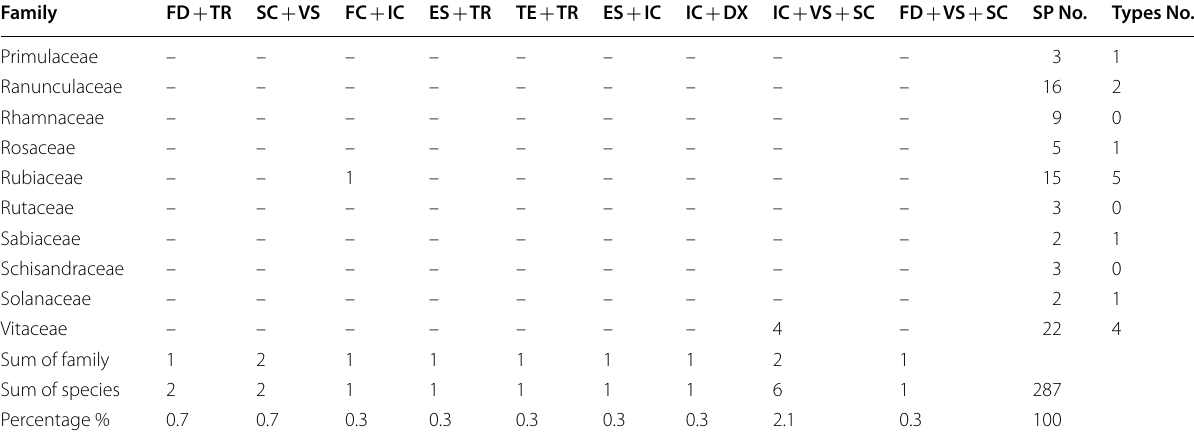
xylem of four regular gaps as quarter-lobes. The fur- rowed xylem is divided into two groups according to the discontinuity (FD) or continuity (FC) of the cam- bium. Discontinuity cambium results in the inclu- sion of fragments of the original concentric cam- bium within the phloem wedges, which are radially lined by wide rays (Pace et al. 2009). A continuous cambium produces secondary phloem that contains tanniniferous cells and druse crystals, or the scleren- chyma is composed of large sclereid clusters or bands of fiber-sclereids to form a stratified phloem (Pace et al. 2009). The cambium continuity also can be divided into shallow or deep split types by the depth of the phloem wedges (Angyalossy et al. 2015). ments of the xylem and phloem are present in seg- ments alternating with very wide xylem and phloem rays, and also called as xylem in plates (Carquist 1991, 2001). Angyalossy et al. (2012) defined this fea- ture as axial vascular elements in segments. 5. Fissured stem/dispersed xylem (DX): this cambial variant is defined as: irregularly shaped, disoriented strands of xylem and phloem associated with frag- ments of vascular cambium spread throughout a parenchymatous matrix; or the dispersed nature of xylem and phloem strands results from the ruptur- ing of the vascular cambium by parenchyma cells (Ayensu and Stern 1964; Cabanillas et al. 2017). This cambial variant type is derived from non-lignified parenchyma proliferation and is called dispersed xylem segments, or is more cracked than the normal xylem, also known as fissured/blocks xylem. The pri-